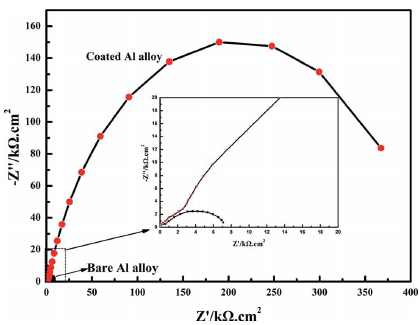
Figure 8. Nyquist plot of graphene coated Al alloy and bare Al alloy and magnification of one segment. Reprinted from [105] with permission; Copyright Royal Society of Chemistry 2014.